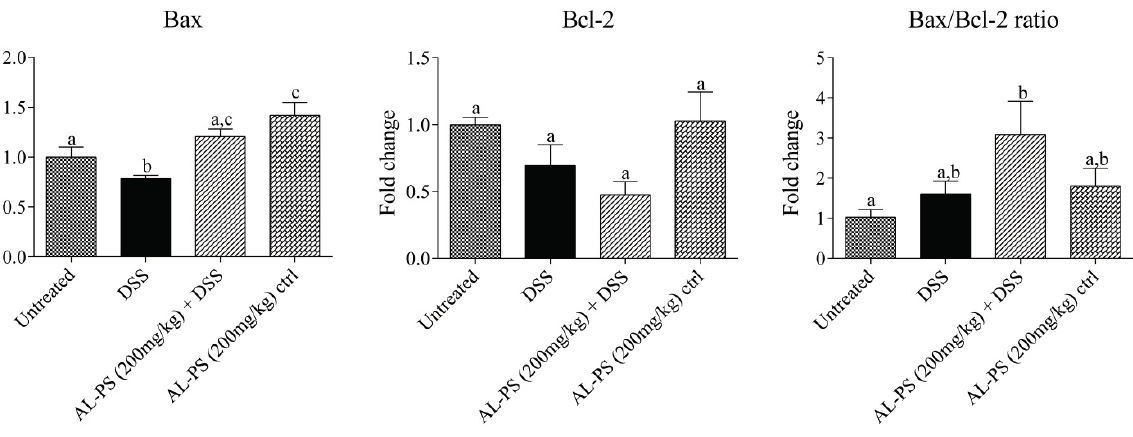
Figure 6. Effect of AL-PS on gene expression of (apoptosis promoter) and Bcl-2 (apoptosis inhibitor), and Bax/Bcl-2 ratio in DSS-induced colitis. RNA was isolated from colonic tissue and relative mRNA expression was measured by real-time RT-PCR. Results are reported as fold change relative to negative control (untreated) animals and data represent means ± SEM of n = 6 mice/group. Different letters indicate statistically significant differences at p <